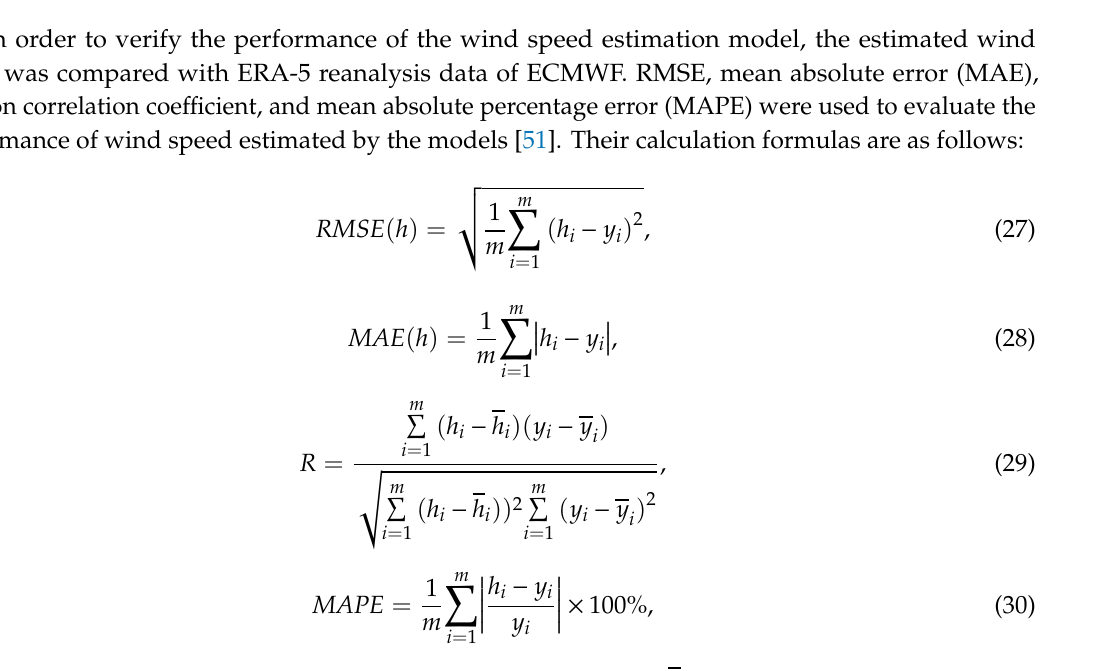
Figure 11. Specular point trajectory distribution. The red trails represent the locations of the reflection points, the green patches represent the Earth’s land, and the light blue patches represent the oceans. ( a ) 02:00–02:30 UTC on 14 June 2020, ( b ) 02:00–02:30 UTC on 20 June 2020, ( c ) 02:00–02:30 UTC on